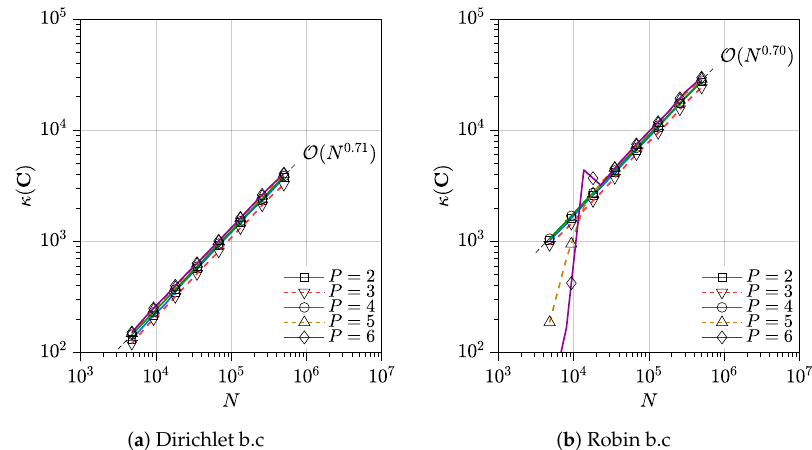
Figure 7. Condition number of the sparse matrix C , Ω :